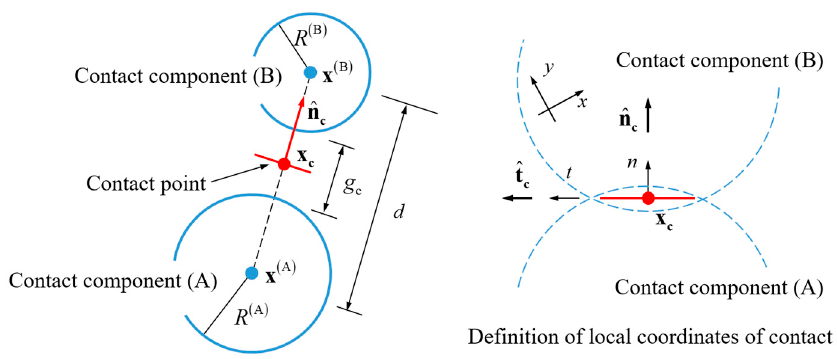
ˆ t , respectively, as and c